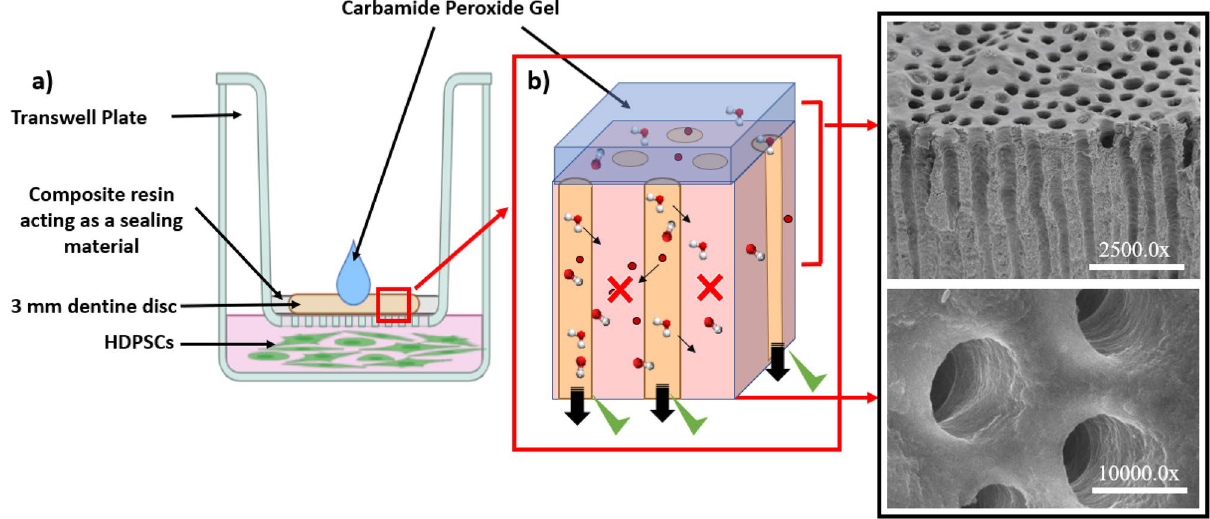
Figure 3. ( a , b ) Schematic depicting a cultured sample of HDPSCs exposed indirectly to CP drop through dentine